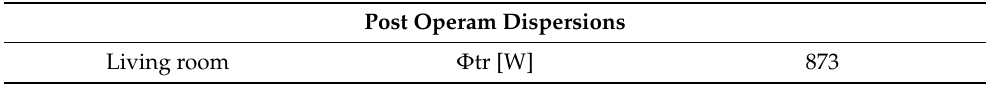
Table 7. Living room: simulated dispersions; post operam monitoring period; climatic zone C.